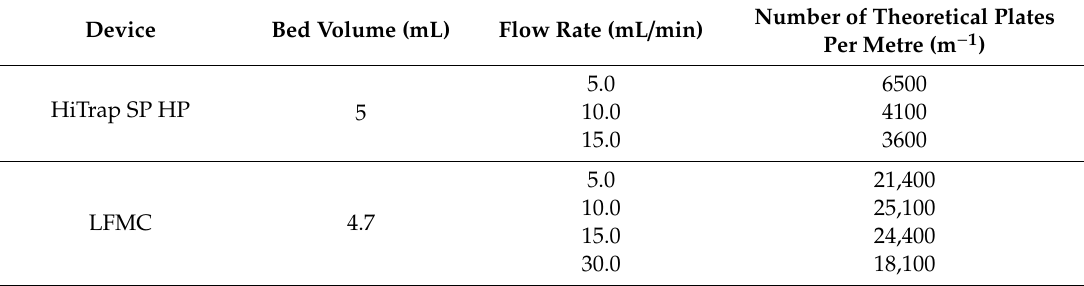
Table 2. Number of theoretical plates per metre (N / m) in the HiTrap SP HP column and LFMC device at di ff erent flow